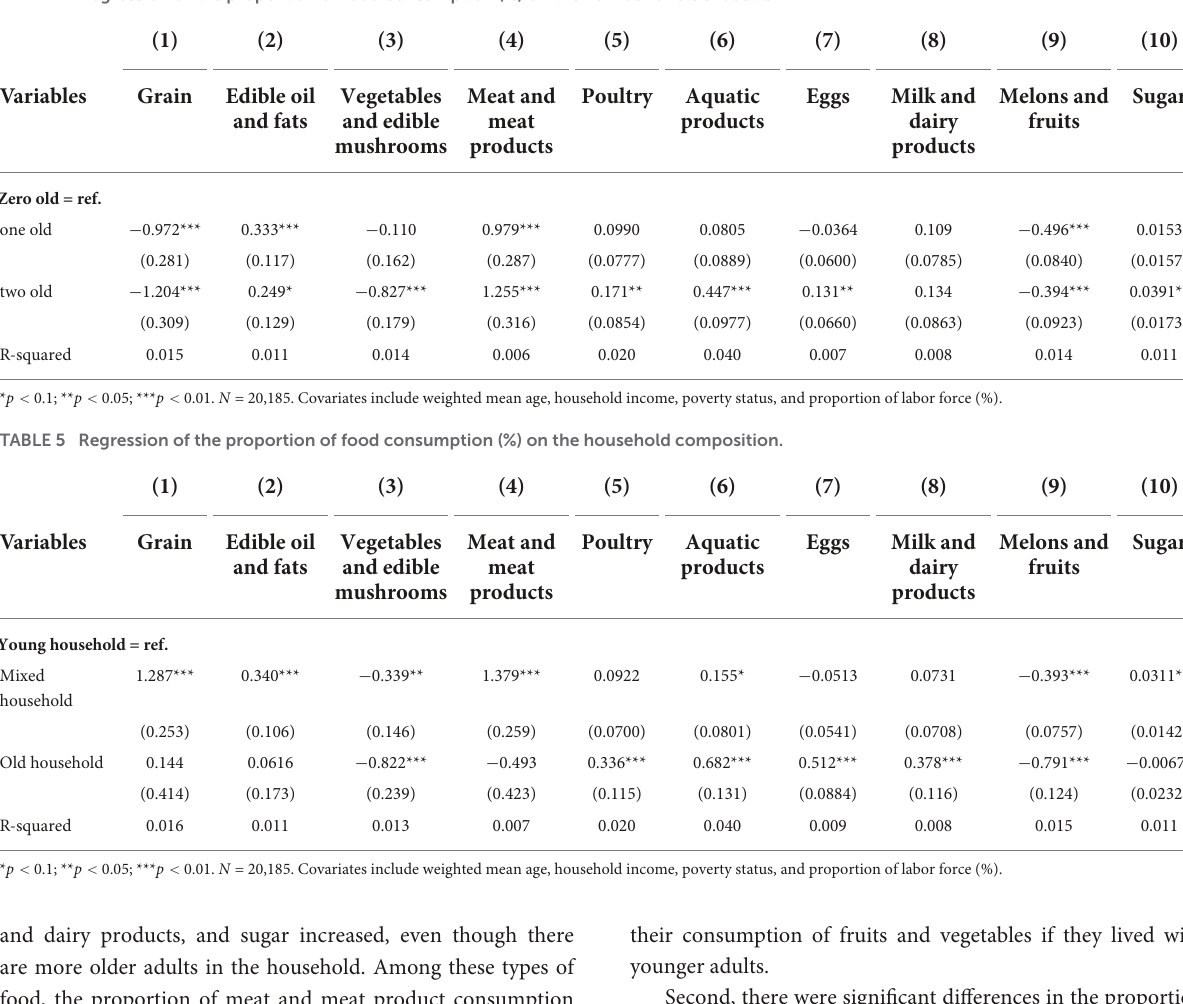
TABLE 4 Regression of the proportion of food consumption (%) on the number of older adults.